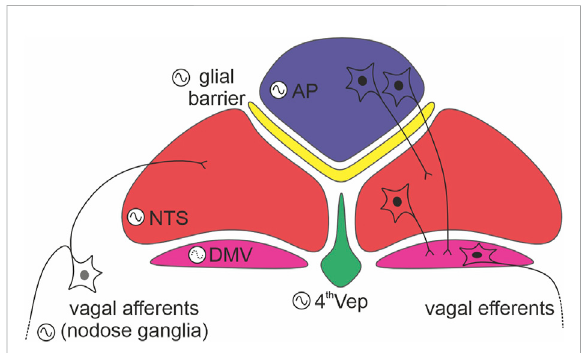
FIGURE 2 Internal connections between dorsal vagal complex (DVC) oscillators. A schema depicting readily de fi ned components of the DVC: the area postrema (AP; in blue), glial barrier (in yellow), nucleus of the solitary tract (NTS; in red), dorsal motor nucleus of the vagus nerve (DMV; in purple), and ependymal layer lining the fourth ventricle (4thVep; in green). Neurons indicate the main direction of synaptic communication amongst the oscillators. Note, that the DMV (forming vagal efferents) is classi fi ed as a weak oscillator (dotted line in its oscillation